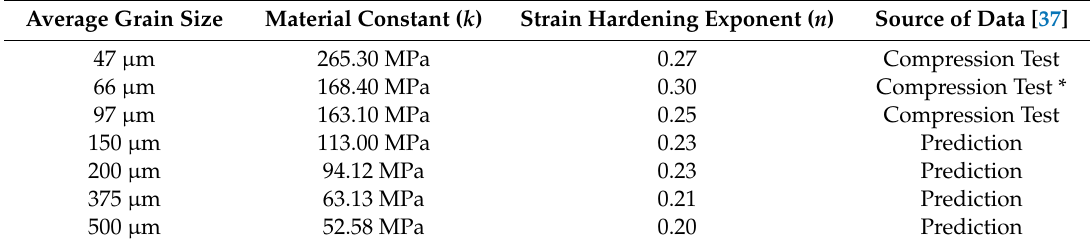
Figure 6. The considered grain sizes and shapes (boundaries) in this study.